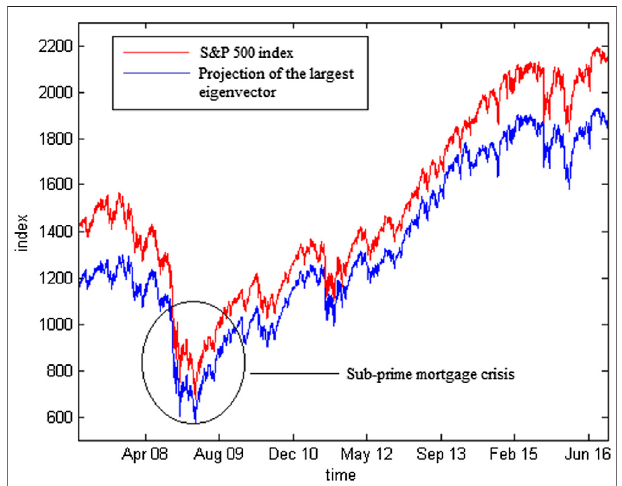
FIGURE 6 | To validate how good the Eigen vectors, we can perform a comparison of projections of the largest eigenvector component (blue) from matrix C withtheS&P500index(red)ontheS&P500dailysharepricedatafor the period of January 1, 2007 until October 28, 2016. This indicates that the method mainly follows the patterns